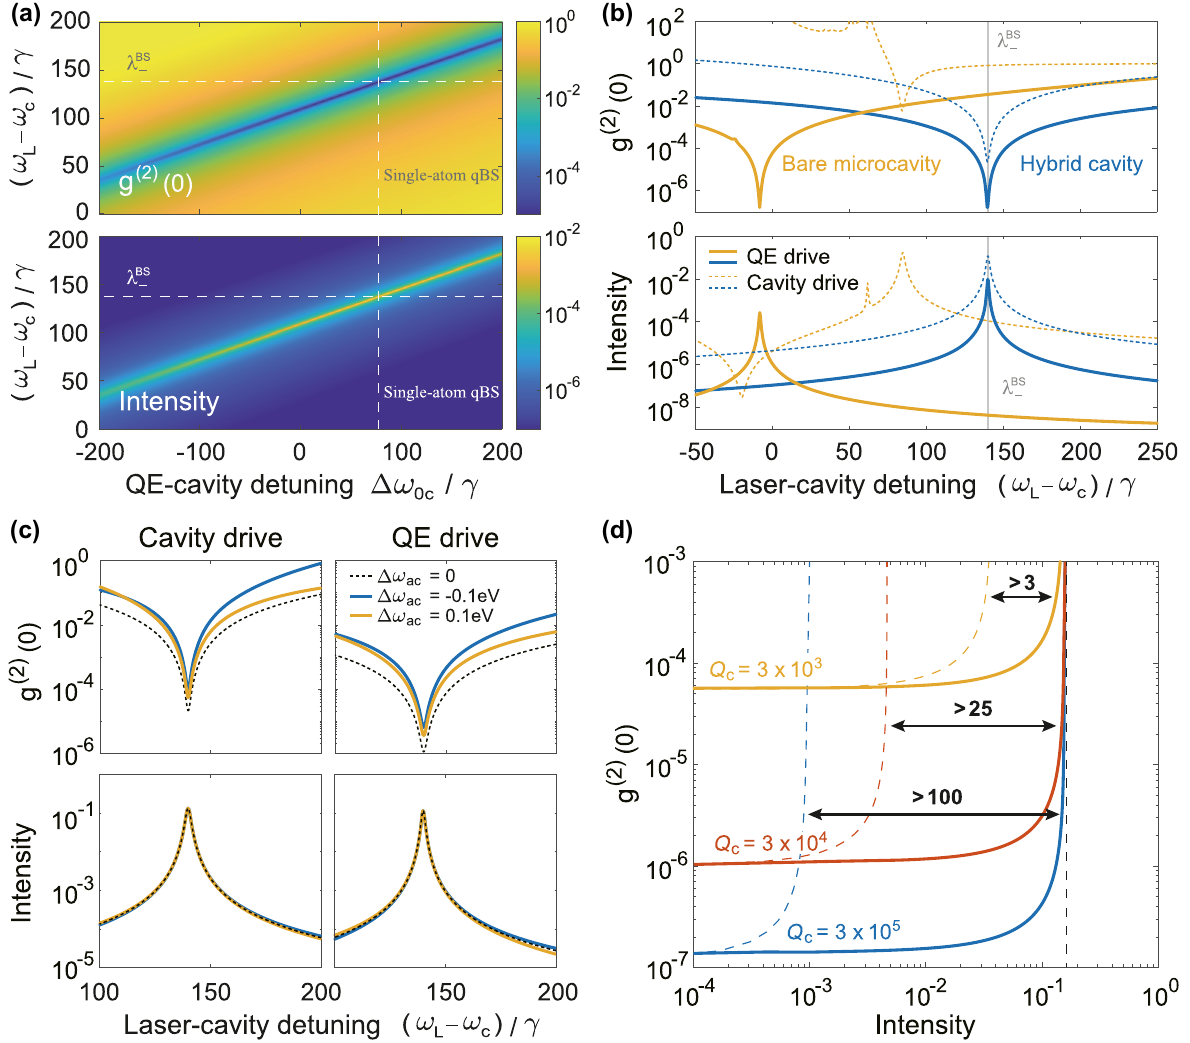
Figure 2: Single-atom qBS for single-photon generation. (a) The zero-time-delay correlation function g (2) (0) (upper panel) and intensity (lower panel) in the cavity-driven case as the function of and the laser-cavity detuning, with 𝜔 the laser frequency. The vertical and horizontal dashed lines correspond to QE-cavity detuning Δ 𝜔 0c L and the eigenenergy of single-atom qBS, respectively. (b) The g (2) (0) (upper panel) and intensity (lower panel) versus the optimal Δ 𝜔 0c laser-cavity detuning for bare microcavity (yellow lines) and hybrid cavity (blue lines) with single-atom qBS for QE drive (solid lines) and cavity drive (dashed lines). The light gray lines indicate the location of 𝜆 BS − . The driving strength is 𝛺 = 0.1 𝛾 for QE drive, and 𝛺 = 𝛾 for cavity drive. (c) The g (2) (0) (upper panel) and intensity (lower panel) versus laser-cavity detuning for hybrid cavity with three different . The driving strength is 𝛺 = 𝛾 . (d) The intensity-purity curves for the hybrid cavity (solid lines) and bare plasmon-photon detuning Δ 𝜔 ac = Δ 𝜔 BS for hybrid cavity, while Δ 𝜔 of bare microcavity microcavity (dashed lines) with different quality factors under QE drive. Here, Δ 𝜔 0c 0 c 0c = 3 × 10 3 , Q = 3 × 10 4 and Q = 3 × 10 5 , respectively. The vertical black dashed line indicates the are 1960 𝛾 , 1000 𝛾 , and 320 𝛾 for Q c c c achievable maximum intensity of hybrid cavity. Parameters of the hybrid cavity are kept the same as those in Figure 1 unless specially noted, = 1.618 eV and the QE’s decay rate 𝛾 = 10 μ eV are kept constant throughout this work as the where the microcavity resonance frequency 𝜔 c reference